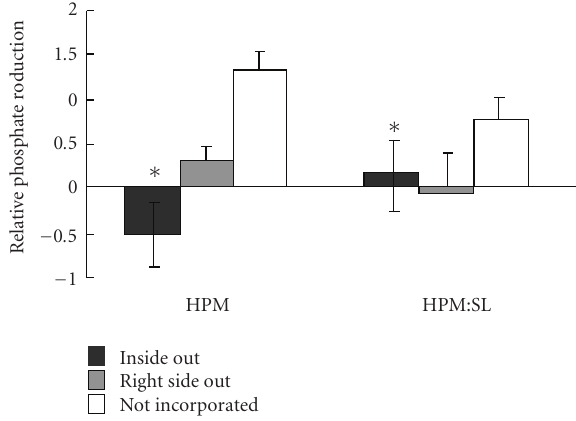
Figure 6: Orientation of Na + K + -ATPase in HPM alone and in HPM: SL proteoliposomes measured by the sidedness assay. Proteoliposomes were created by nitrogen filtration using HPM or HPM: SL lipids (1:1; wt: wt), incubated ± ouabain ± detergent and then function (PO 4 production from ATP) was measured and used to calculate sidedness [33] to determine the relative amount of Na + K + -ATPase that was facing inside out, right side out, or was not incorporated. Di ff erences between HPM proteoliposomes and HPM: SL proteoliposomes are indicated by ∗